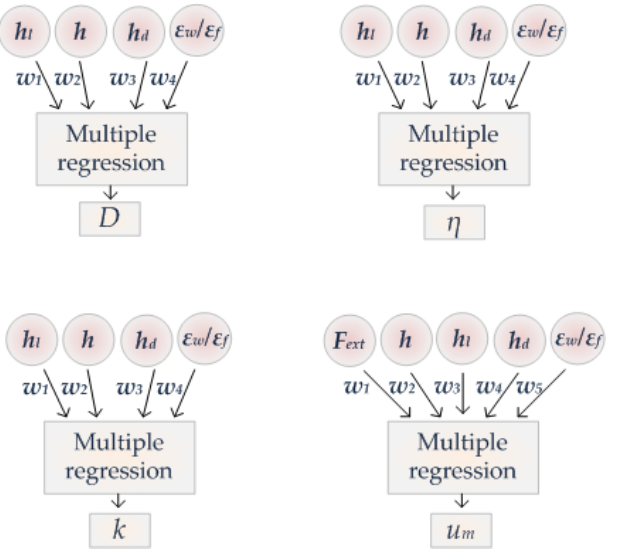
Figure 2. Machine learning (ML) multi-regression diagram. Outputs are not correlated to each other and are derived from a different ML network.